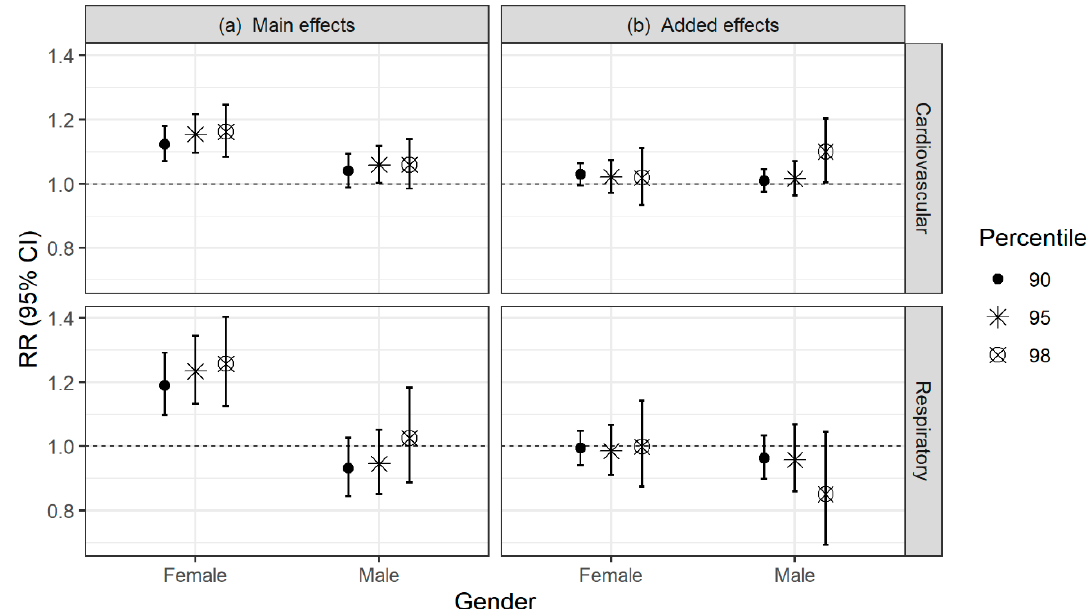
Figure 2. Overall relative risk of heat wave-related mortality of elderly from cardiovascular and respiratory diseases by gender in the MRSP. Considering two contributions of heat: ( a ) Main effects and ( b ) Added effects. The different symbols represent the 90th, 95th and 98th percentiles of maximum temperature. The main effect is predict between the median maximum temperature among heat-wave days for each percentile 90th, 95th, 98th (33.6 °C, 34.4 °C and 35.15 °C, respectively) versus the 75th percentile of annual maximum temperature distribution (30.4 °C).